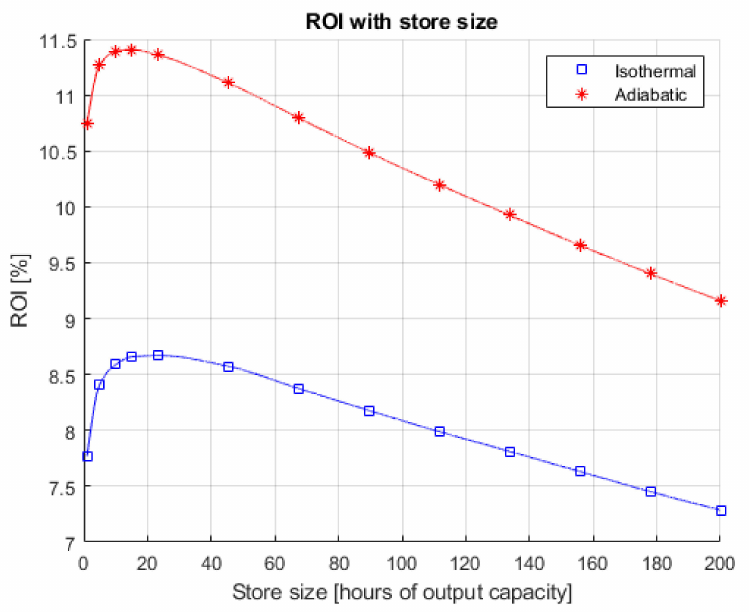
Figure 14. The relationship between one-year return on investment and storage capacity for a system with the maximum allowable inlet swept